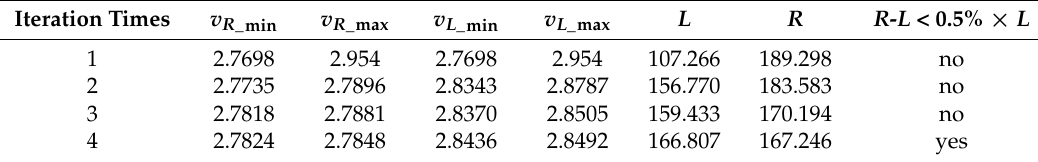
Table 3. Iteration result of the fault location at 167 km.